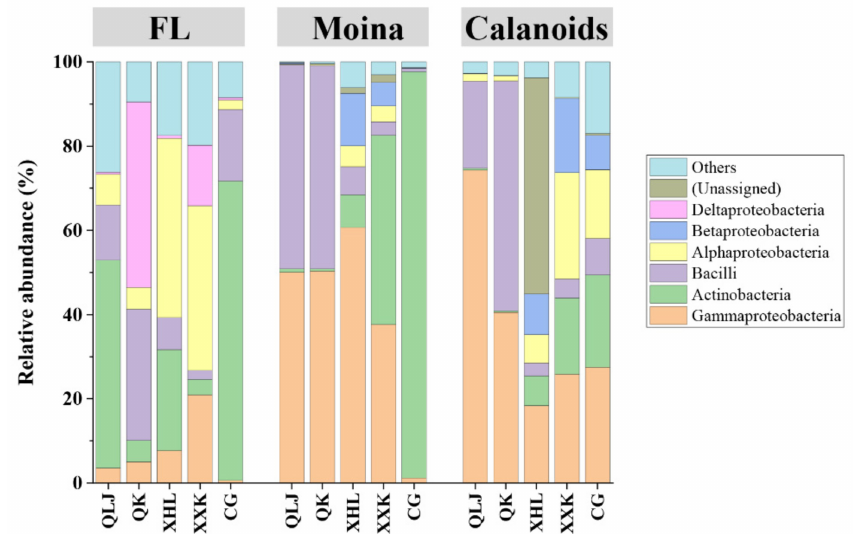
Figure 2. Relative abundance of top 6 classes in microbes associated with Moina and Calanoids in five freshwater lakes. Samples are listed as XXK, QK, XHL, QLJ, and CG. FL, free − living bacteria; ZA, zooplankton − associated